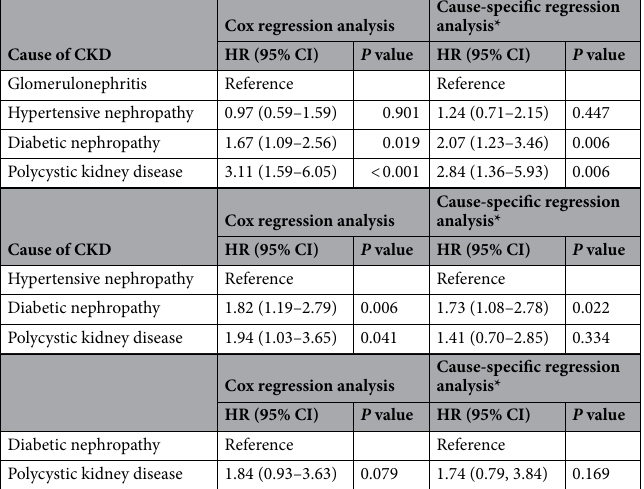
Table 3. Relative risk for composite outcome of CVD and all-cause death according to the CKD causes. *For the composite outcome of CVD and death, cause-specific regression analysis was conducted as a competing risk analysis using the kidney failure as competing event considering the undetected CVD after starting kidney replacement therapy. CI, confidence interval; CKD, chronic kidney disease; CVD, cardiovascular disease; HR; hazard ratio.